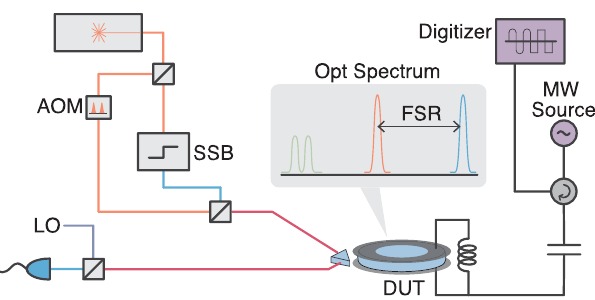
Fig. 1 Schematic of the experiment. The laser is divided into two parts: the optical pump and the signal. The pump is pulsed via an acousto-optic modulator (AOM). The signal part is frequency up-shifted using a single sideband modulator (SSB). The optical pump and signal are combined and sent to the device under test (DUT) in a dilution refrigerator via an optical fi ber. The microwave signals are sent and received using a single port via a circulator. Optical and microwave output signals are measured with heterodyne Fig. 1. The Hamiltonian is then given as